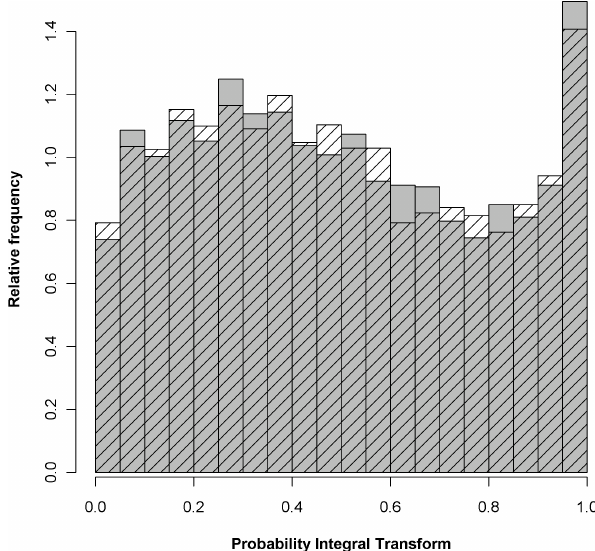
Fig. 6. Probability Integral Transform histograms illustrating the re- liability of forecasts made using selected predictors (solid grey bars) and WAPABA and lag-1 streamflow as predictors (hatched bars).